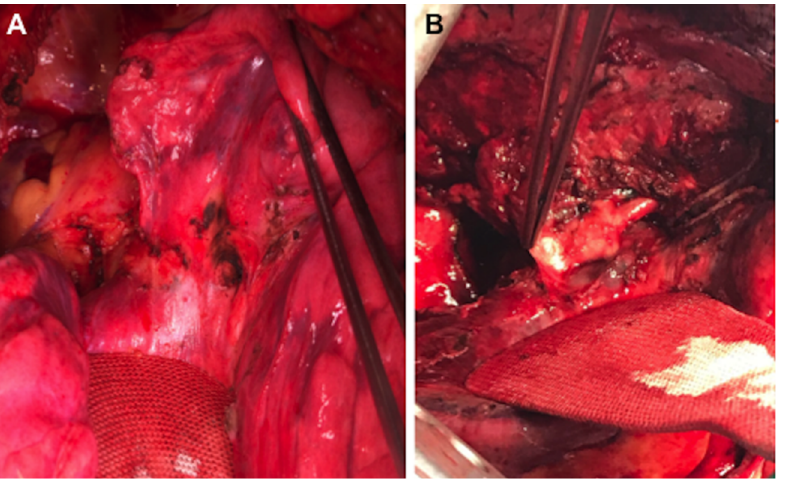
Figure 5. Intraoperative view of two operated cases after treatment with erlotinib ( A ) and pembrolizumab ( B ). A. Presence of diffuse fibrotic tissue in the fissure. B, Presence of perivascular fibrosis and scars making more difficult vessels isolation.